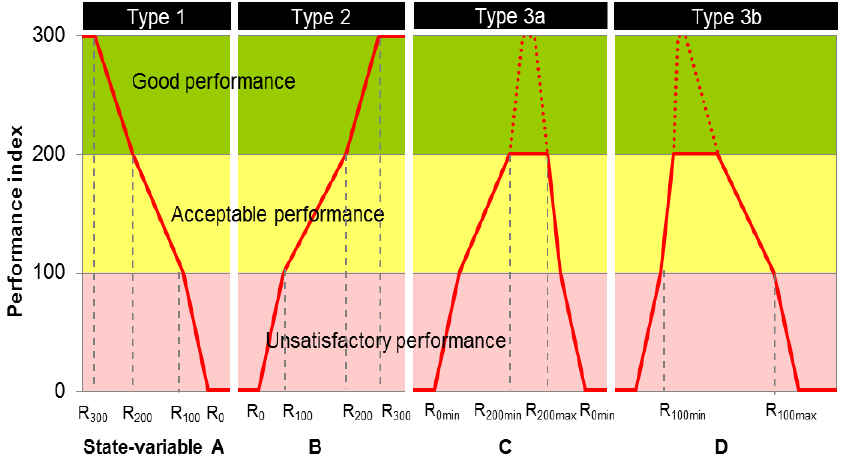
Figure 1. The types of performance functions to assess the operational performance of WWTPs.